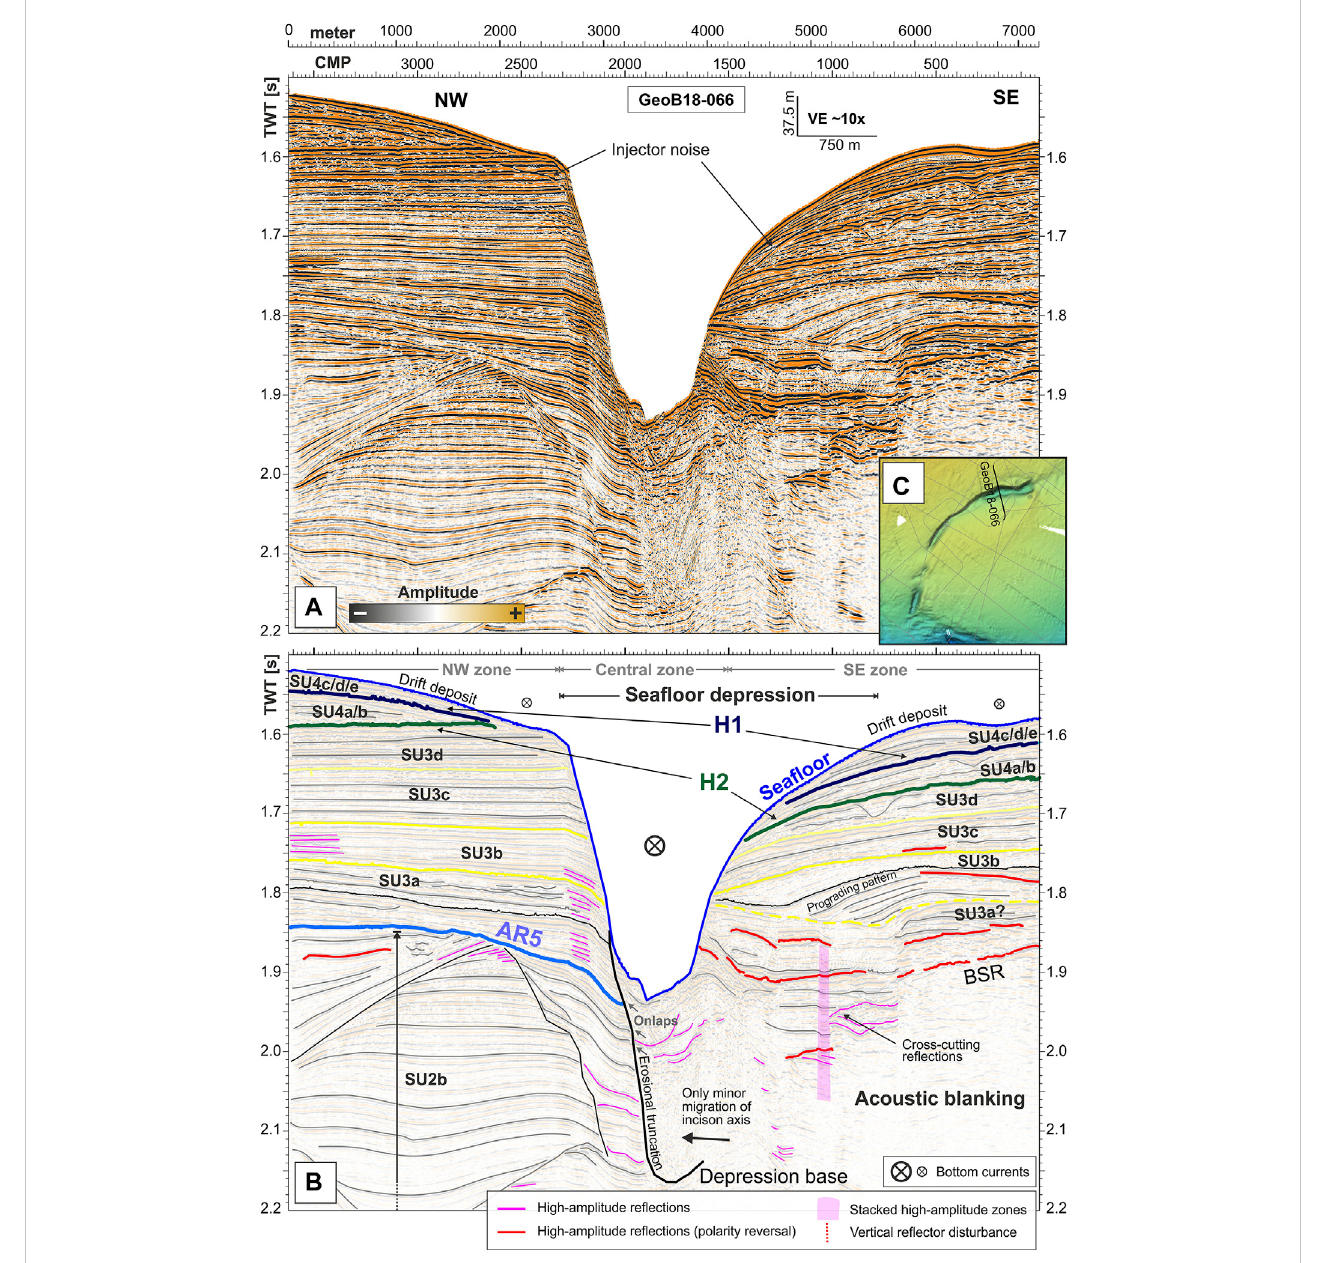
FIGURE 8 Seismic pro fi le GeoB18-066 as (A) migrated section and (B) interpreted line drawing showing a prominent sea fl oor incision truncating horizontally alignedre fl ectionpatterns.Interpretations ofstratigraphichorizonsH1,H2,andAR5andseismicunits(SU3a-d)arebasedonPreuetal.(2012)(cf.Section2.3). Differentamplitudeanomalieslikehighamplitudepatterns,re fl ectionswithreversedsea fl oorpolarity,andverticalhighamplitudezonesindicatethepresence of gas and potential fl uid migration. Some pro fi le parts below 2 s TWT are masked by acoustic blanking. (C) Bathymetry map showing pro fi le